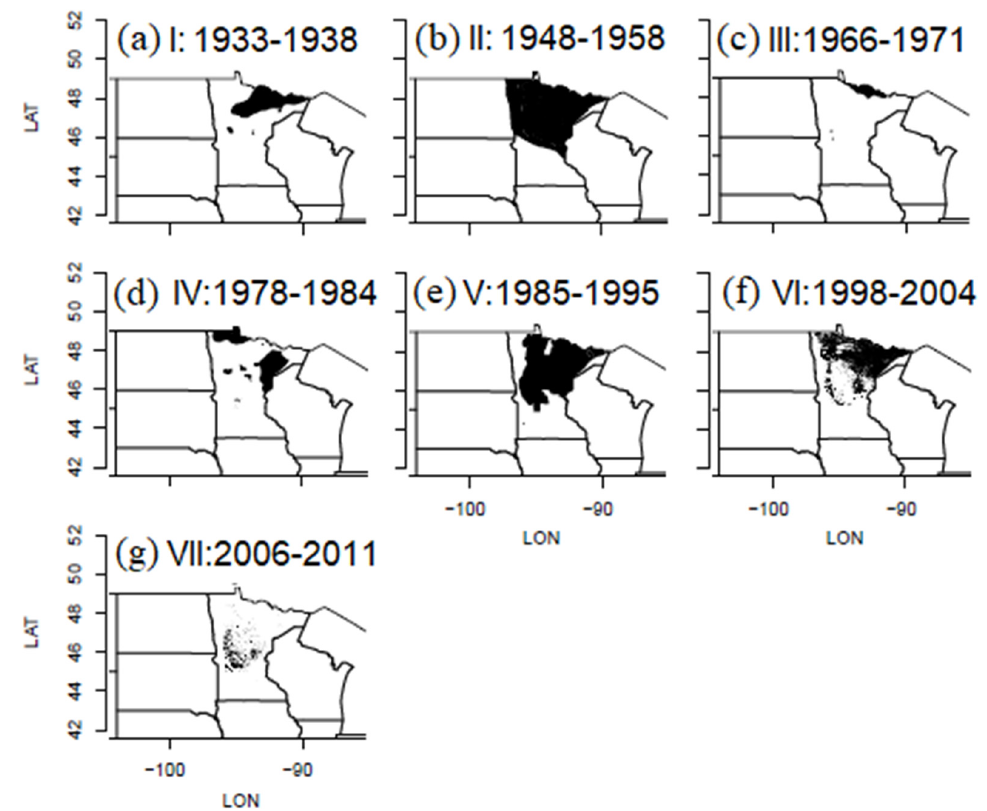
Figure 3 . ( a – g ) Maps of cumulative area defoliated by FTC in Minnesota during each of seven out ‐ break cycles, I–VII, during the years